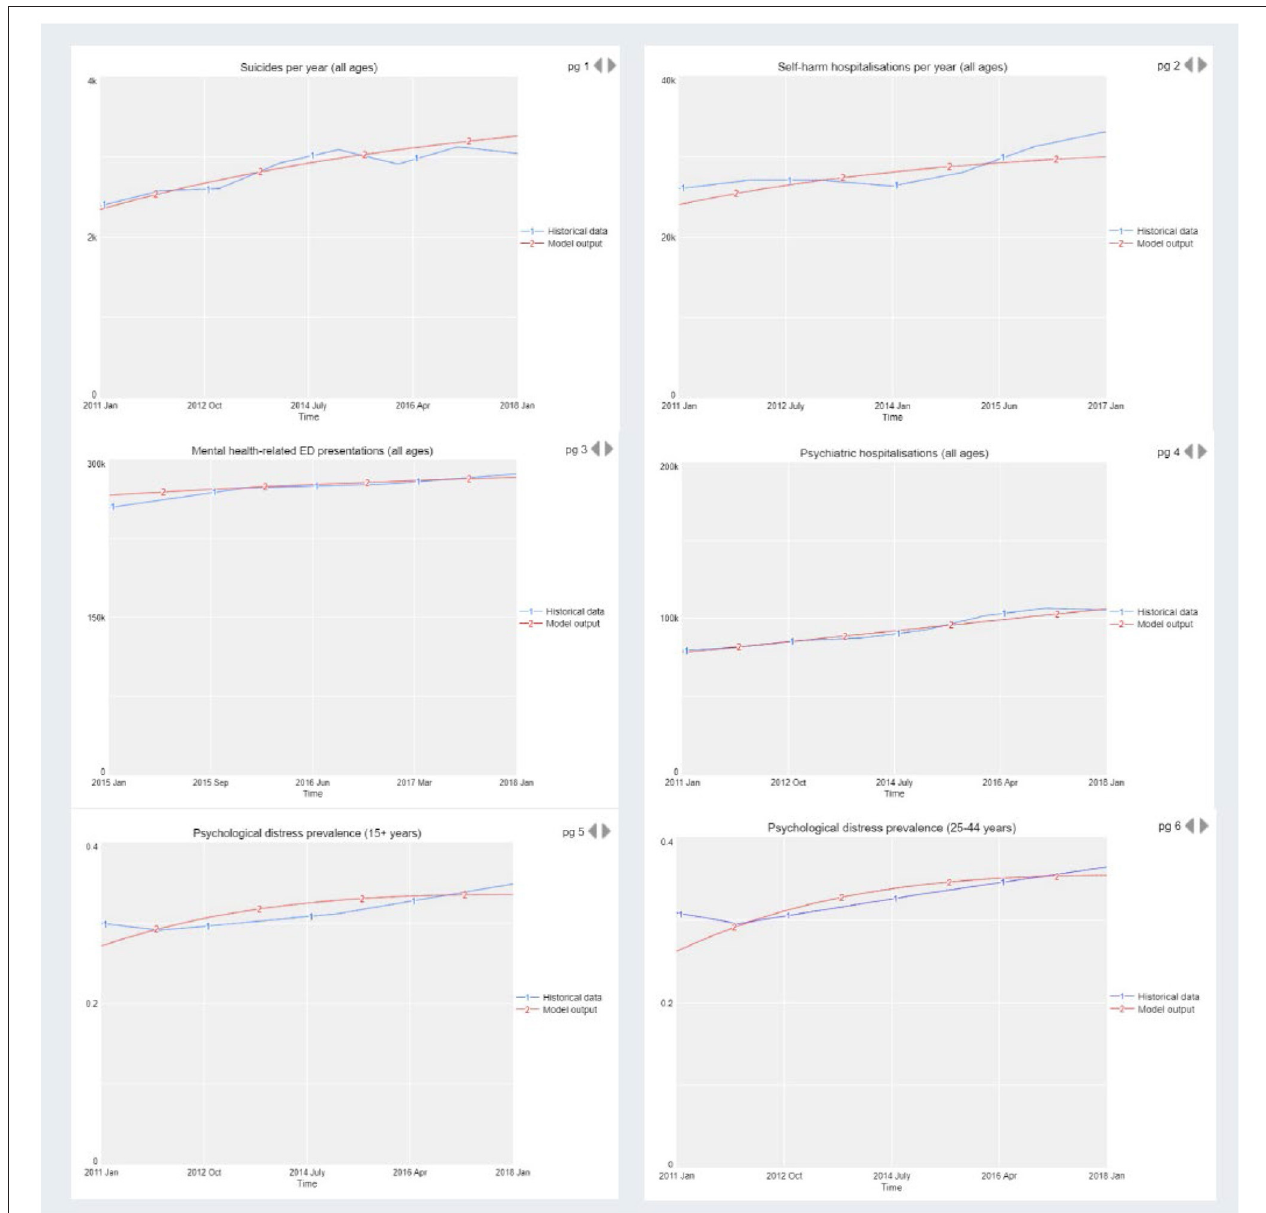
FIGURE 4 | Model validation by comparison of model output with historic time series data across a range of outcome